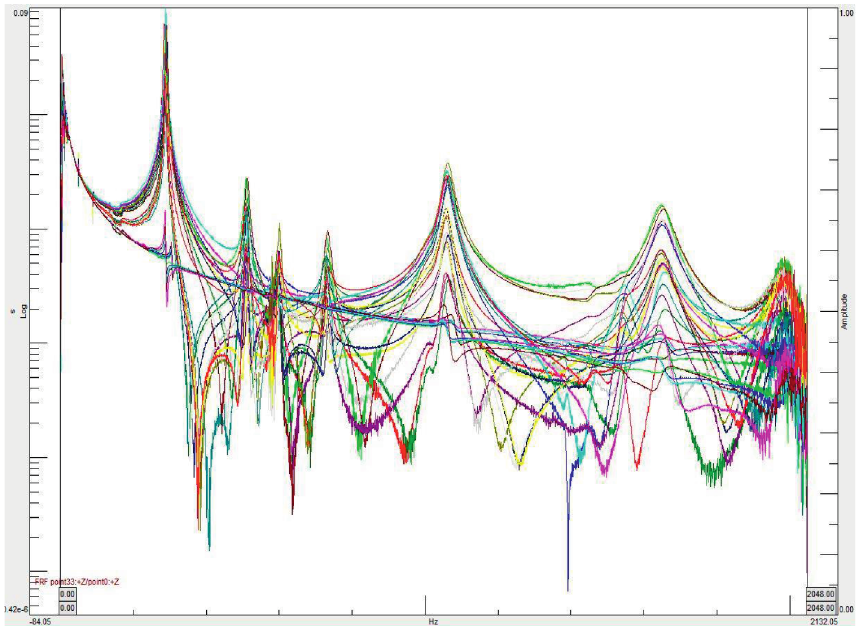
Figure 17: Experimental frequency response function base excitation vs velocity.